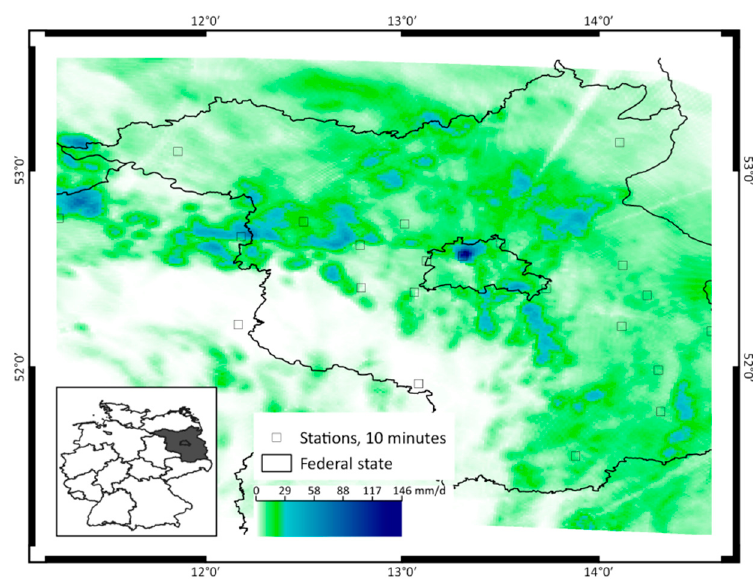
Figure A3. A singular event (dark blue): The rainfall amount on this day was significantly lower elsewhere, as well as the rainfall erosivity (not shown). Data source: RADOLAN RW [36] . The linear features are artifacts due to radar shadows.